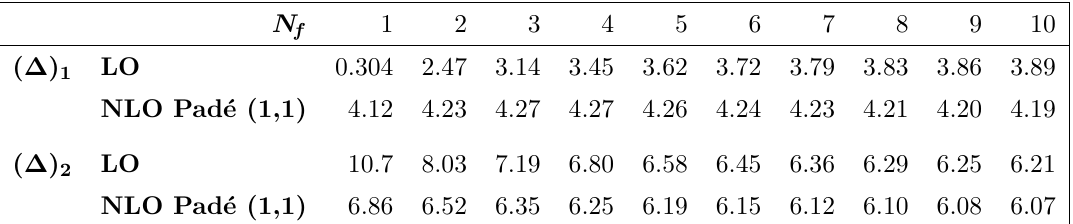
Table 3 . LO and NLO Pad(cid:19)e (1,1) predictions for the scaling dimension of the two (cid:13)avor-singlet four-fermion operators at d = 3 for various values of N f . Only three signi(cid:12)cant digits are being displayed.